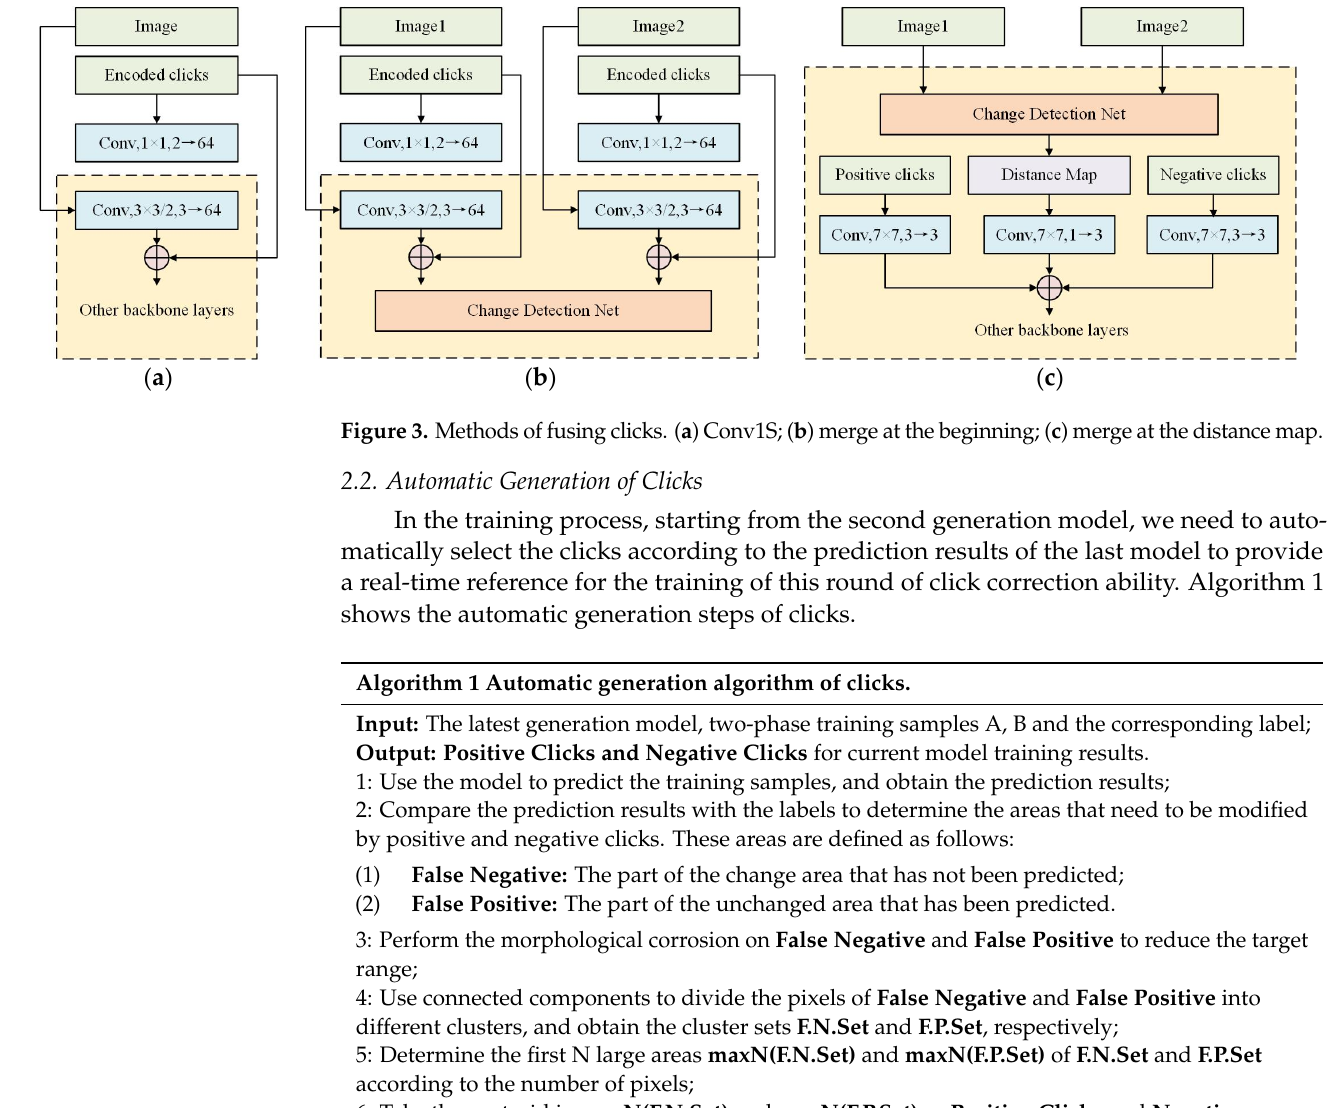
Table 1. Automatic generation algorithm of clicks. Algorithm 1: Automatic generation algorithm of clicks